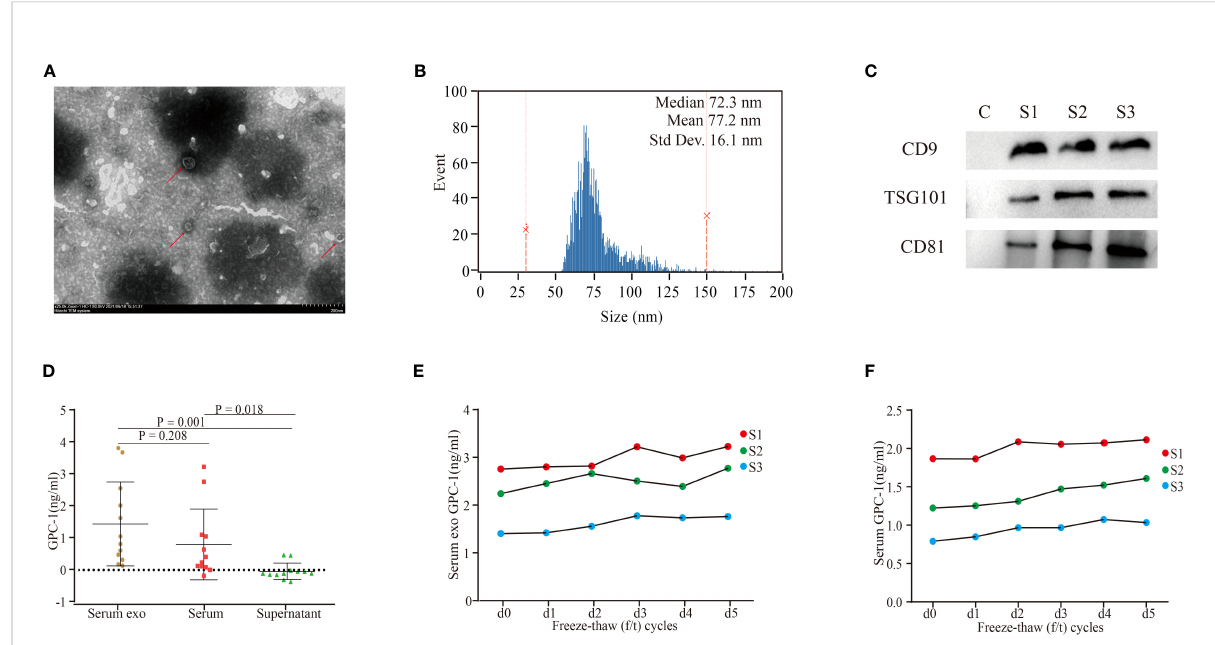
FIGURE 1 Characterization of serum exosomes and GPC-1 expression in serum exosomes and serum. (A) TEM image of exosomes extracted from the serum of patients with PDAC. (B) Nano fl ow cytometry analysis of serum exosomes. (C) Western blot analysis of the serum exosomal markers CD9, TSG101, and CD81. TEM, transmission electron microscopy; PDAC, pancreatic ductal carcinoma. (D) Serum exosomal, serum and exosome-depleted serum supernatant GPC-1 expression levels. Serum exosomal (E) and serum (F) GPC-1 expression levels were stable under 1-5 freeze – thaw